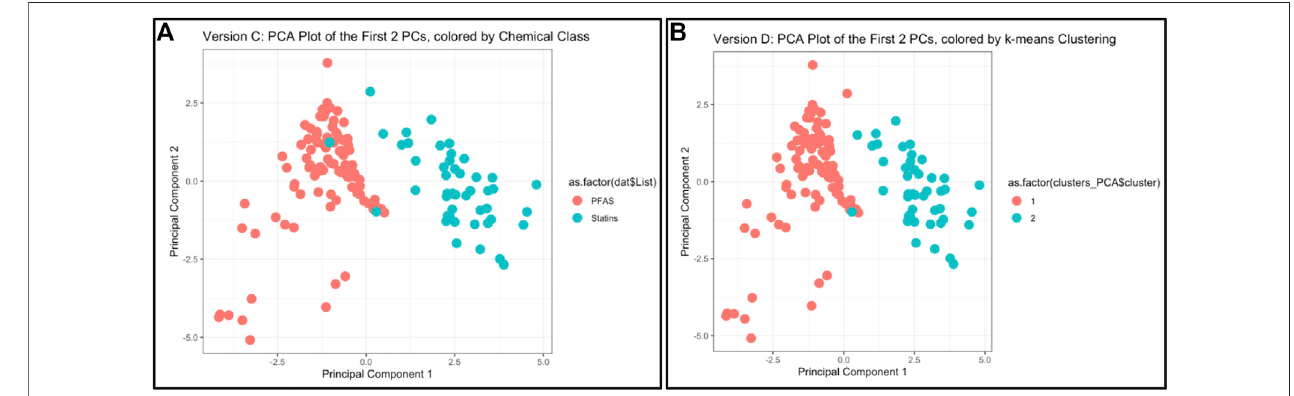
FIGURE4| Exampleresultsandvisualizationsproducedthroughthismachinelearningandpredictivemodelingactivity,basedonanexampledatasetof144PFAS and statins. (A) Principal components were derived to capture the majority of variance amongst physicochemical properties across PFAS and statins, using PCA methods. (B) Chemical classes were predicted using k-means clustering across PCA-reduced components, demonstrating that the predicted chemical classes were almost identical to the actual chemical classes [as shown in (A) ].